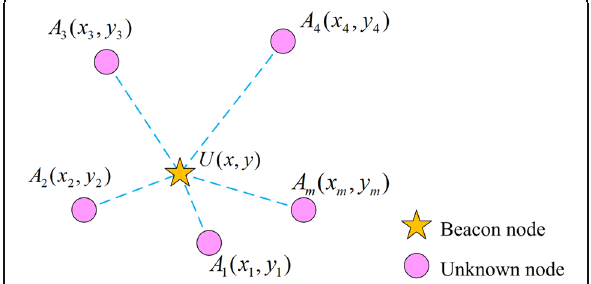
Fig. 4 Maximum likelihood estimation error analysis